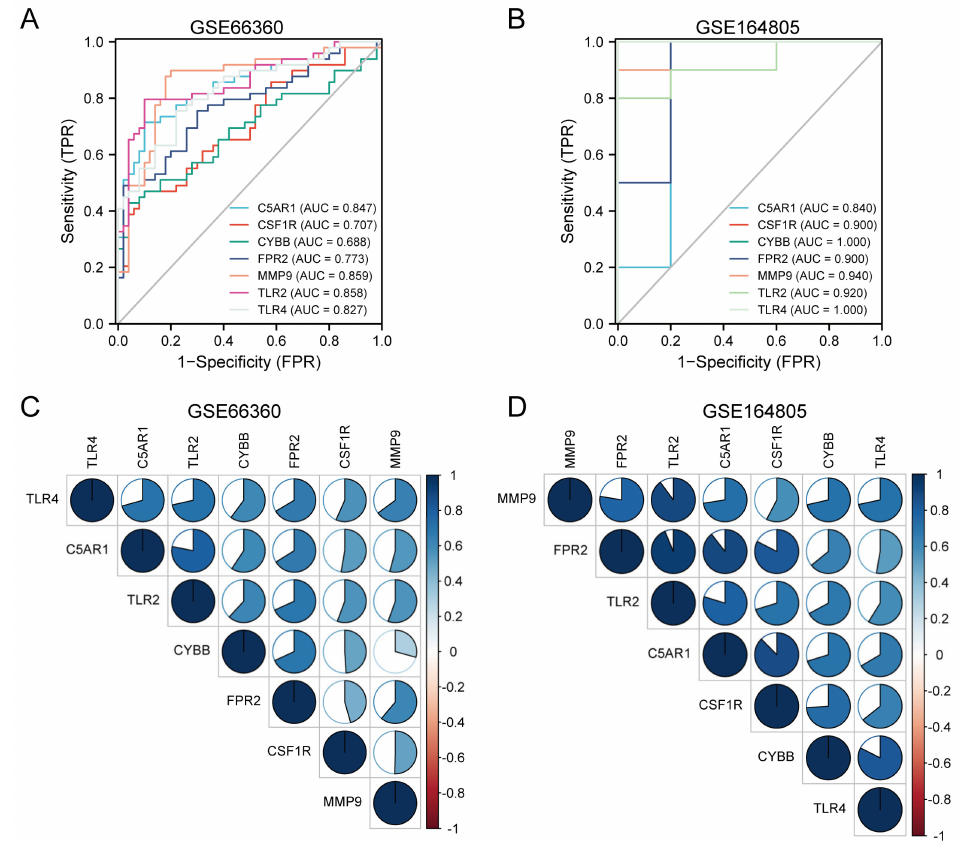
Figure 6. The diagnostic efficacy verification of seven immune-related hub genes and their ex- pressional correlation. ( A , B ) ROC curves of seven immune-related hub genes in GSE66360 and GSE164805 datasets. ( C , D ) Reciprocal correlations between the seven immune-related hub genes. The area size and the color of circles represent the strength of the correlation between genes. The larger the size and the bluer the color, the stronger the